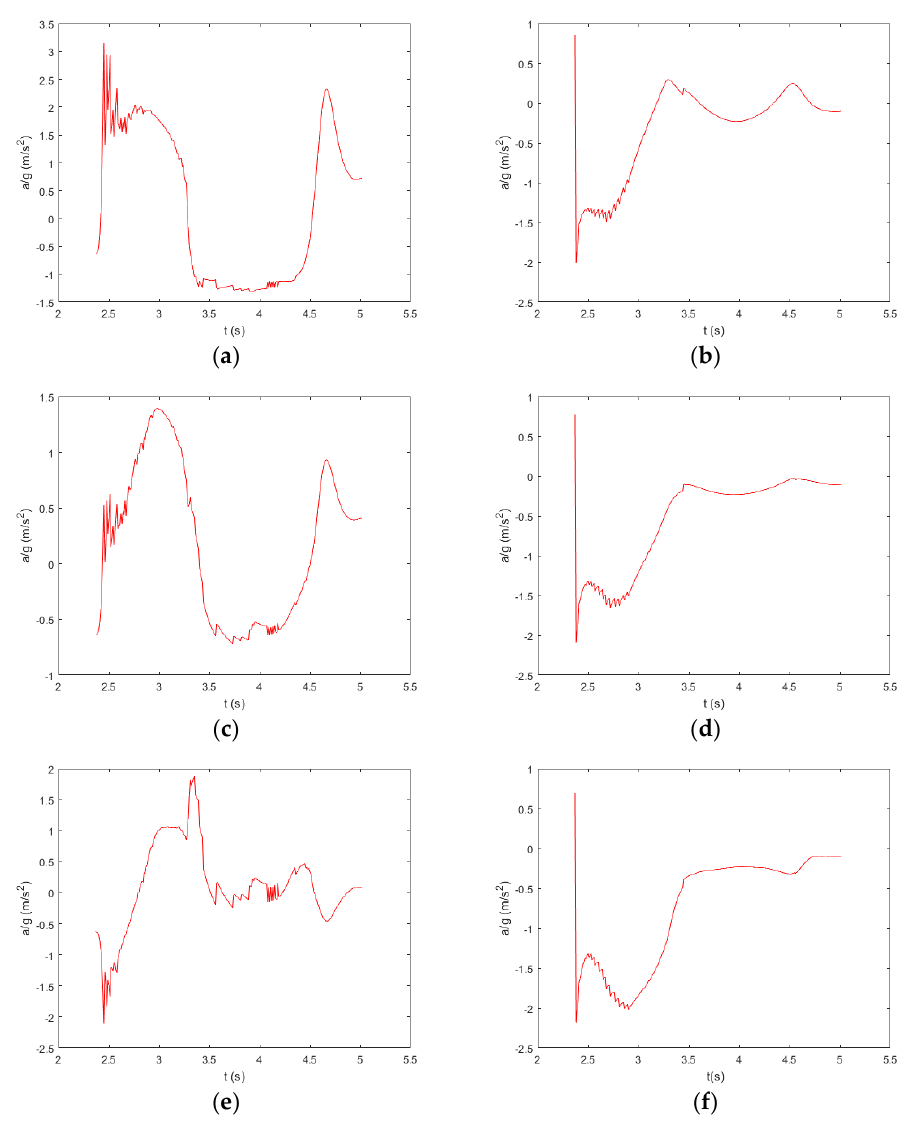
Figure 11. The acceleration of the bow, midship, and stern in the coordinate system of the lifeboat in the direction of 𝑏 3 ( a , c , e ) and in the direction of 𝑏 1 ( b , d , f ).